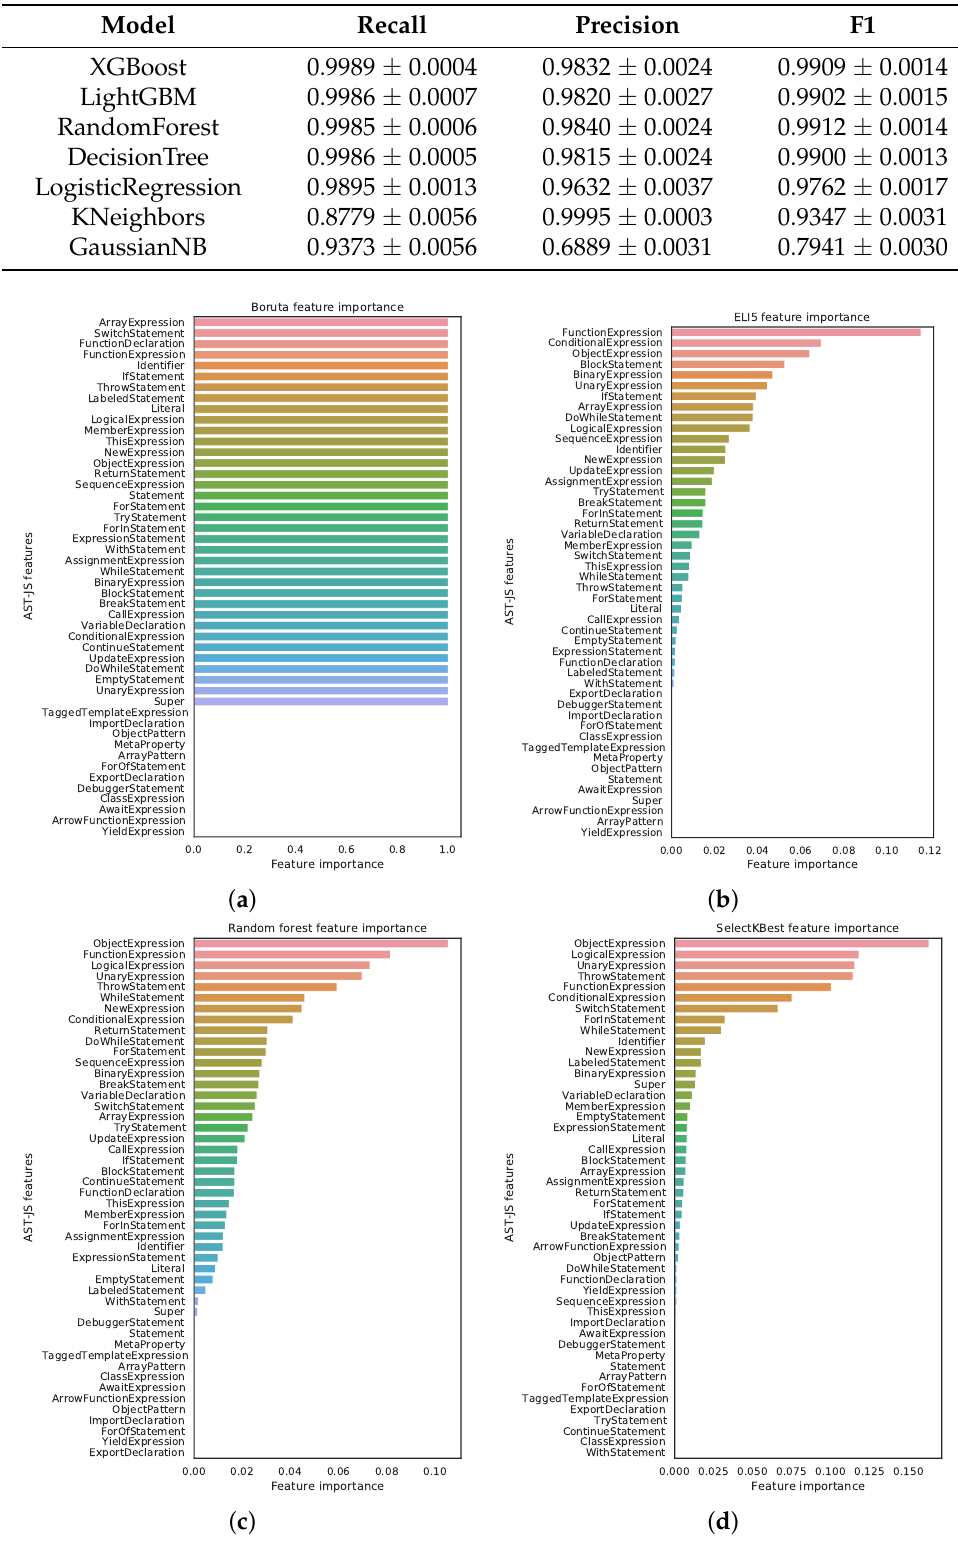
Figure 5. Feature importance assigned to AST-JS by other feature selection methods. ( a ) Boruta; ( b ) ELI5; ( c ) RandomForest; ( d )